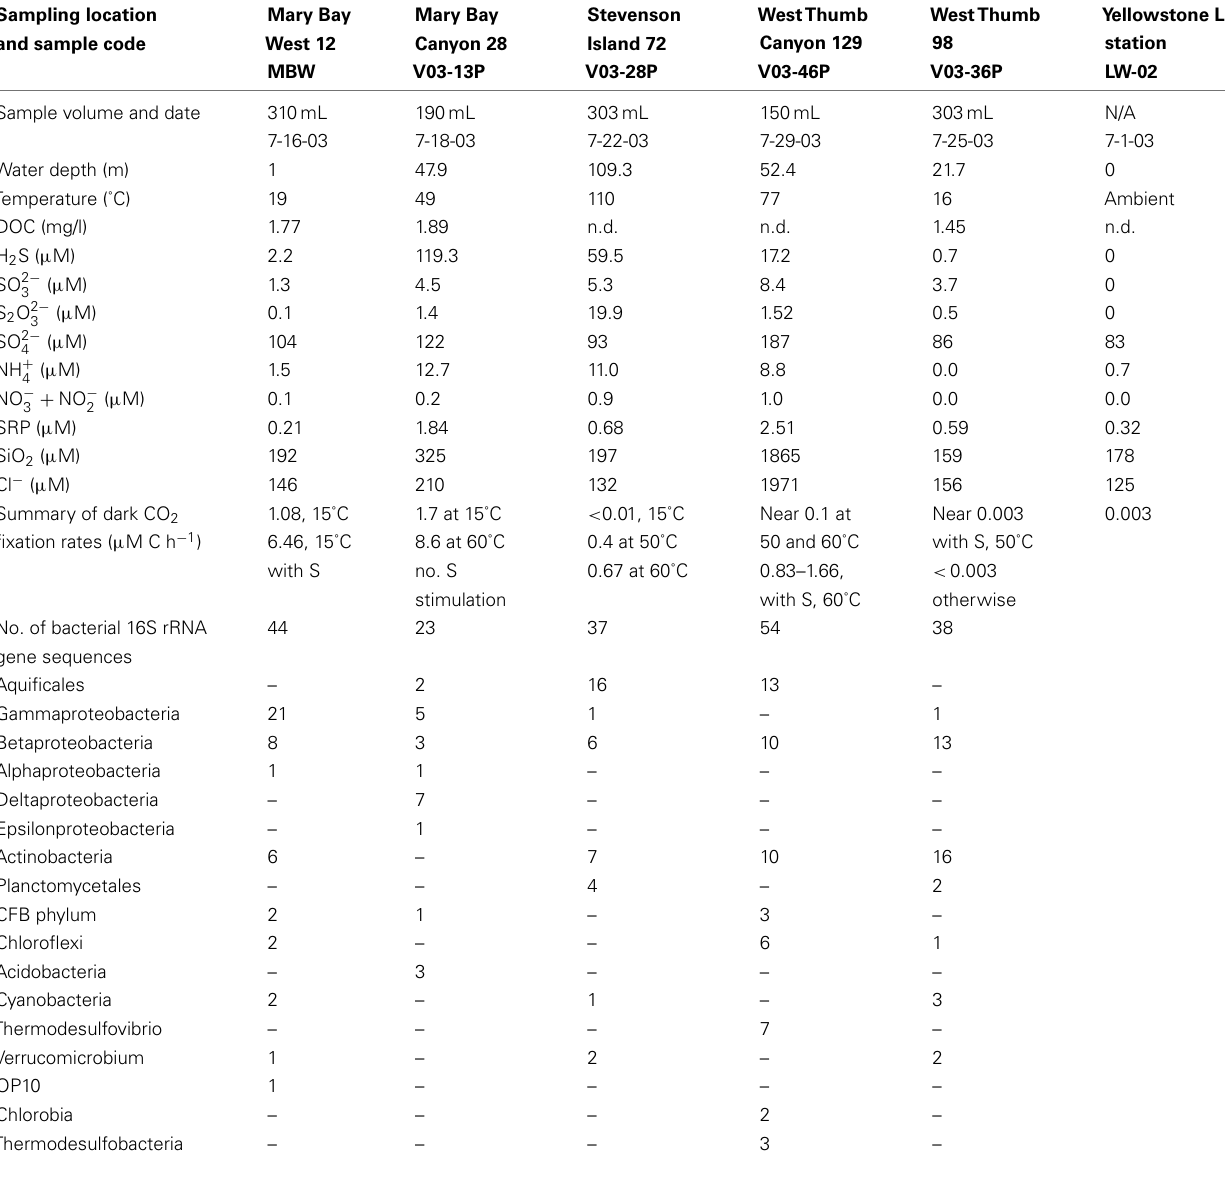
Table 1 | Yellowstone Lake vent samples: summary of chemistry, dark C fixation, and 16S rRNA gene sequence data. Sampling